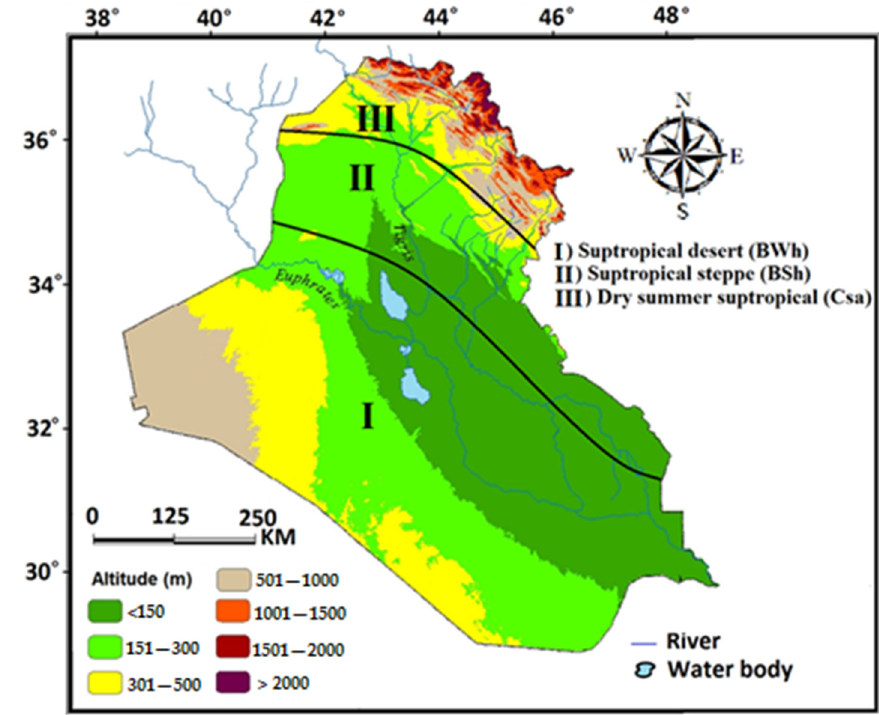
Figure 1. The altitude and climate regions of